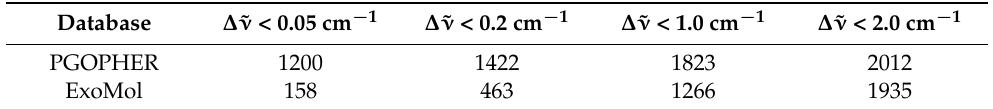
Table 7. Subset CN B-X lines of the PGOPHER and ExoMol data that agree within ∆ ˜ ν of 2461 CN B-X